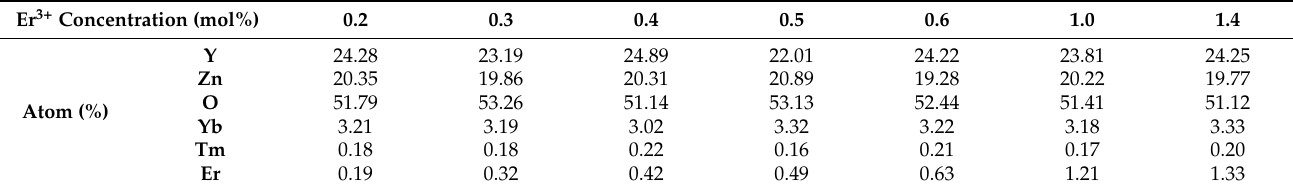
Table 1. Chemical element composition ratio obtained by EDS spectrum.